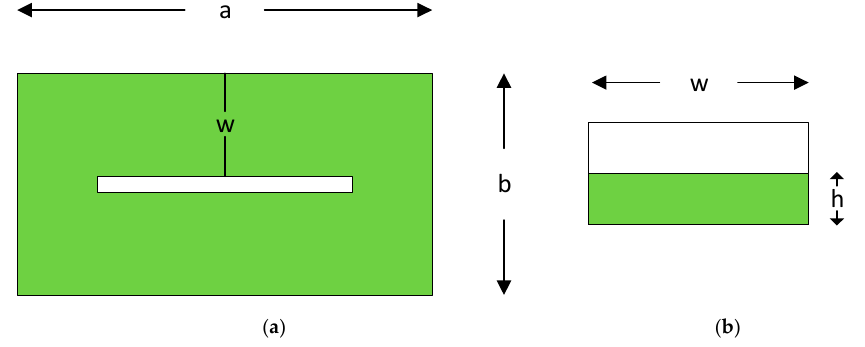
Figure 2. Open raceway pond: ( a ) top view of the open raceway pond; ( b ) flow channel of the open raceway pond.